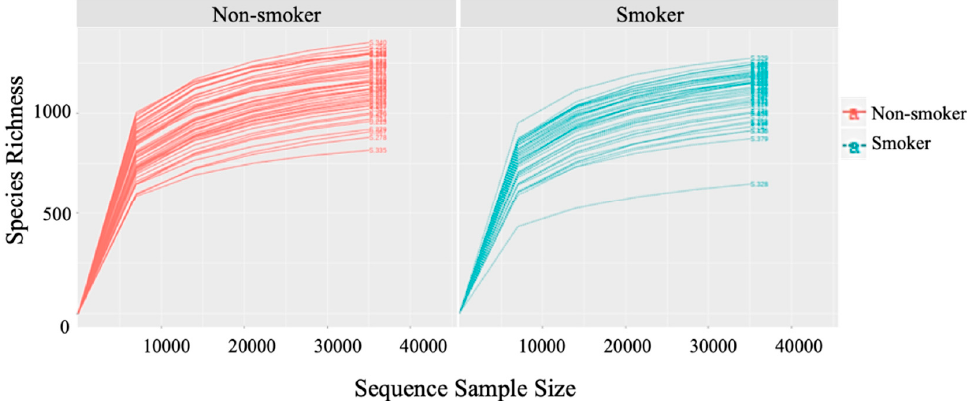
Figure A2 . Rarefication curve using filtered dataset.